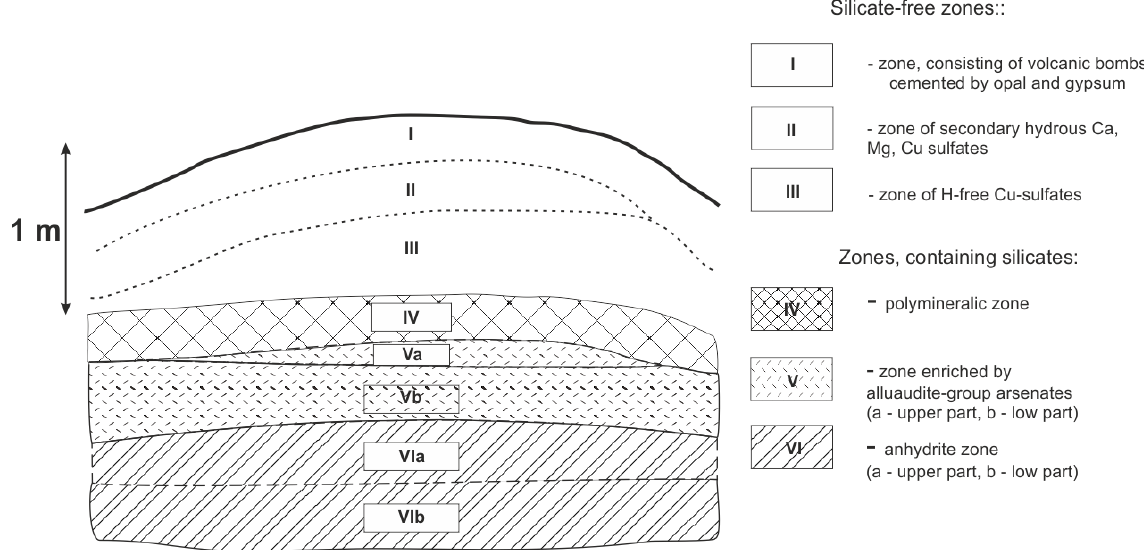
Figure 1. Schematic section across the northern part of the Arsenatnaya fumarole. The scheme is drawn after Pekov et al. (2018a). The detailed description of each zone is given in the cited paper. The mineral diversity of zones containing silicates is listed in Table